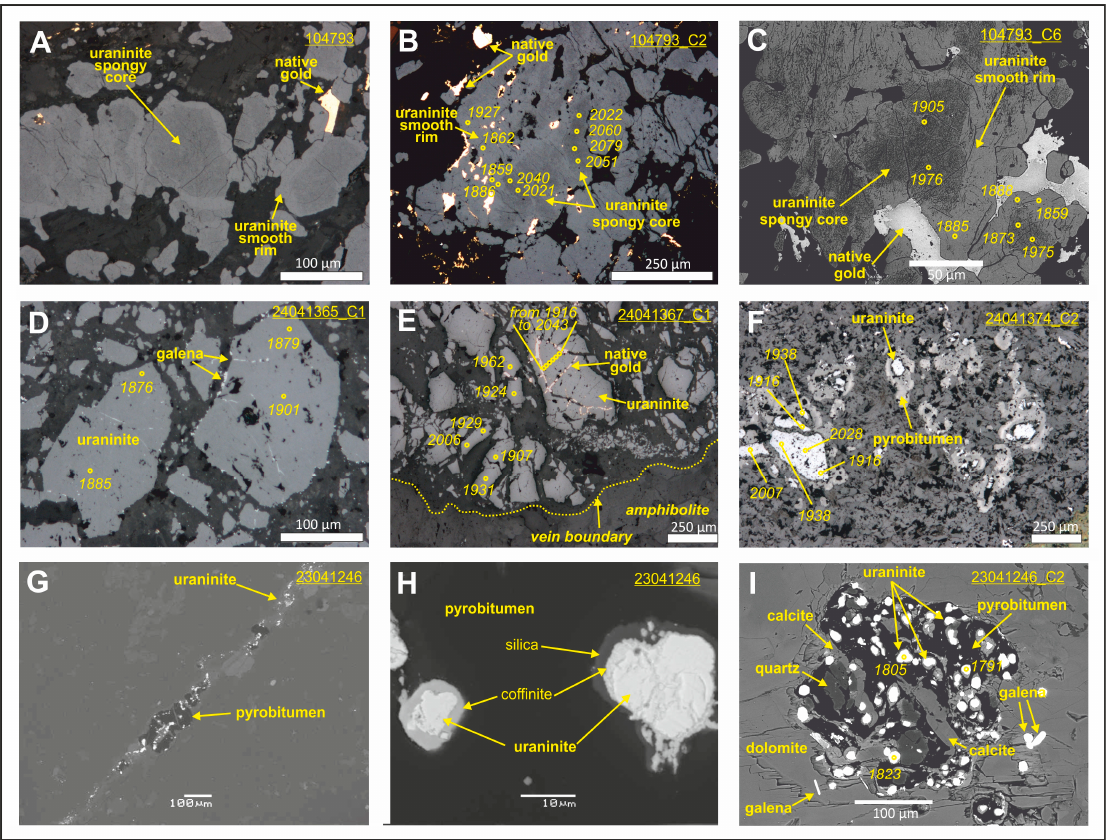
Figure 3. Reflected light photomicrographs ( A – F ) and SEM-BSE images ( G – I ) showing textural varieties of uraninite and locations of some U–Pb analytical spots with ages (Ma). ( A ) Type 1 uraninite with spongy mottled cores and smooth rims and native gold between uraninite grains; ( B ) Type 1 uraninite with native gold in the fractures of the smooth rim of the uraninite crystal and location of U–Pb spot analyses. Note the significant differences between the 207 Pb/ 206 Pb ages in the spongy mottled cores and smooth rims. ( C ) Type 1 uraninite with native gold in the fracture and surface of the smooth rims of crystals and locations of U–Pb spot analyses. ( D ) Type 2 uraninite grains in carbonate matrix and galena in the fractures of uraninite grains. Galena has high radiogenic Pb isotope content [6]. ( E ) Type 2 uraninite grains with galena and native gold in fractures. ( F ) Type 3 uraninite grains encompassed by pyrobitumen. ( G ) Late fracture with Type 3 uraninite and pyrobitumen. ( H ) High resolution SEM-BSE photograph taken on Type 3 uraninite grains encompassed by pyrobitumen. Note the altered rims consisting of coffinite and silica on uraninite grains. ( I ) Type 3 uraninite grains in a pyrobitumen nodule.